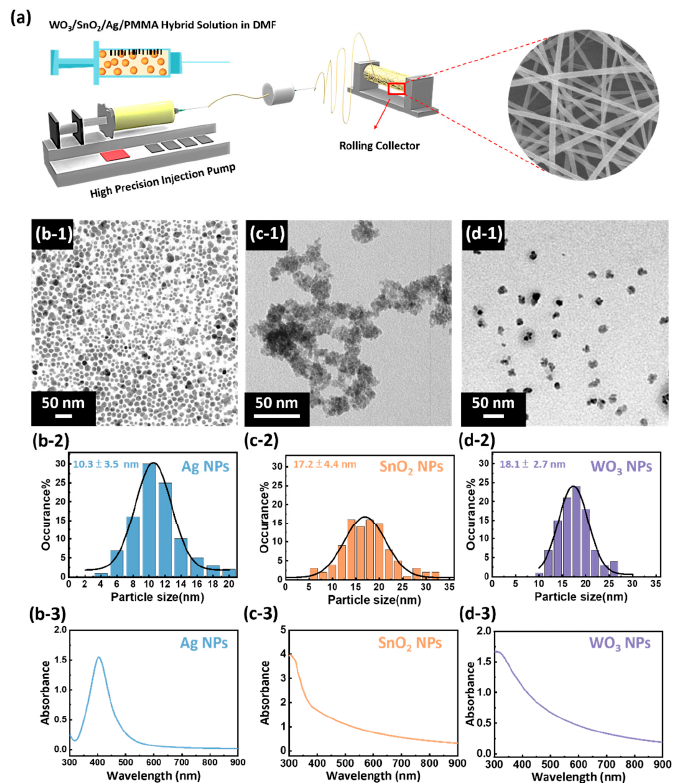
Figure 1. ( a ) The schematic of sensing material preparation. ( b-1 , c-1 , d-1 ) TEM image, ( b-2 , c-2 , d-2 ) the percentage distribution of particles sizes, and ( b-3 , c-3 , d-3 ) UV–vis absorbance spectrum of ( b-1 , b-2 , b-3 ) Ag NPs, ( c-1 , c-2 , c-3 ) SnO 2 NPs, ( d-1 , d-2 , d-3 ) WO 3 NPs. Both the applied voltage and working distance have been shown to have vary- (Figure 2e–g) and WO 3 /SnO 2 /Ag/PMMA (Figure 2i–k) fibers with various applied